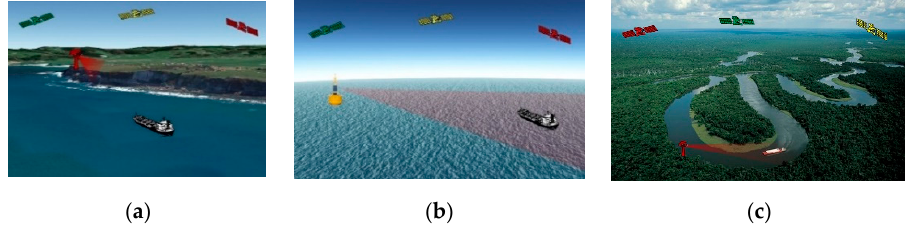
Figure 1. System concept examples of applications: ( a ) littoral traffic monitoring; ( b ) open sea surveillance; and ( c ) river traffic control of remote areas.